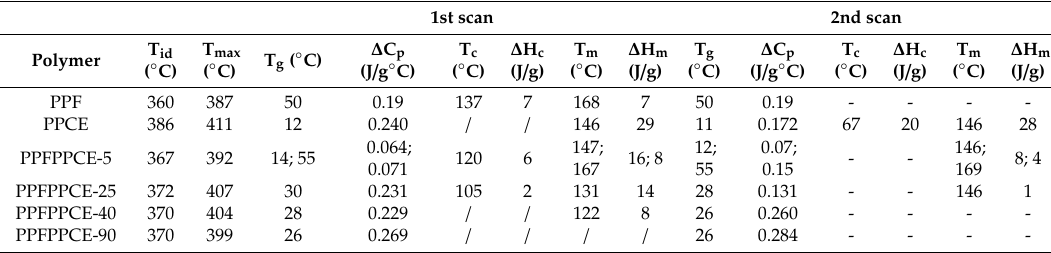
Table 2. Thermal characterization data of PPF, PPCE, and PPFPPCE-t copolymers.